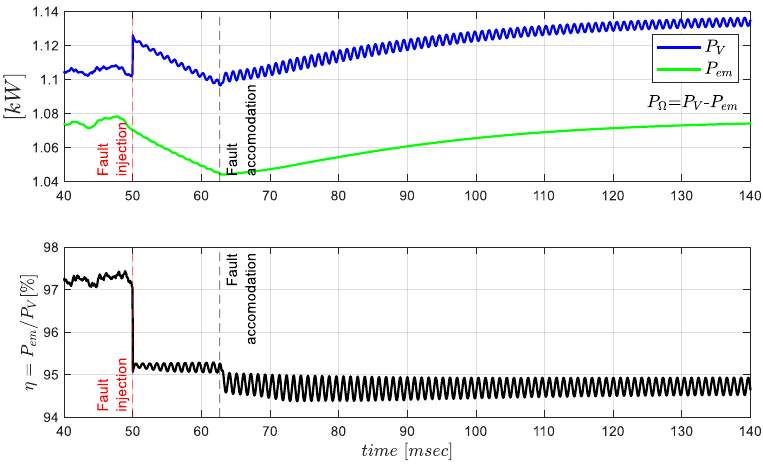
Figure 17. Current phasor trajectory in the Clarke space with open circuit on phase a ( I lim = 92 A).